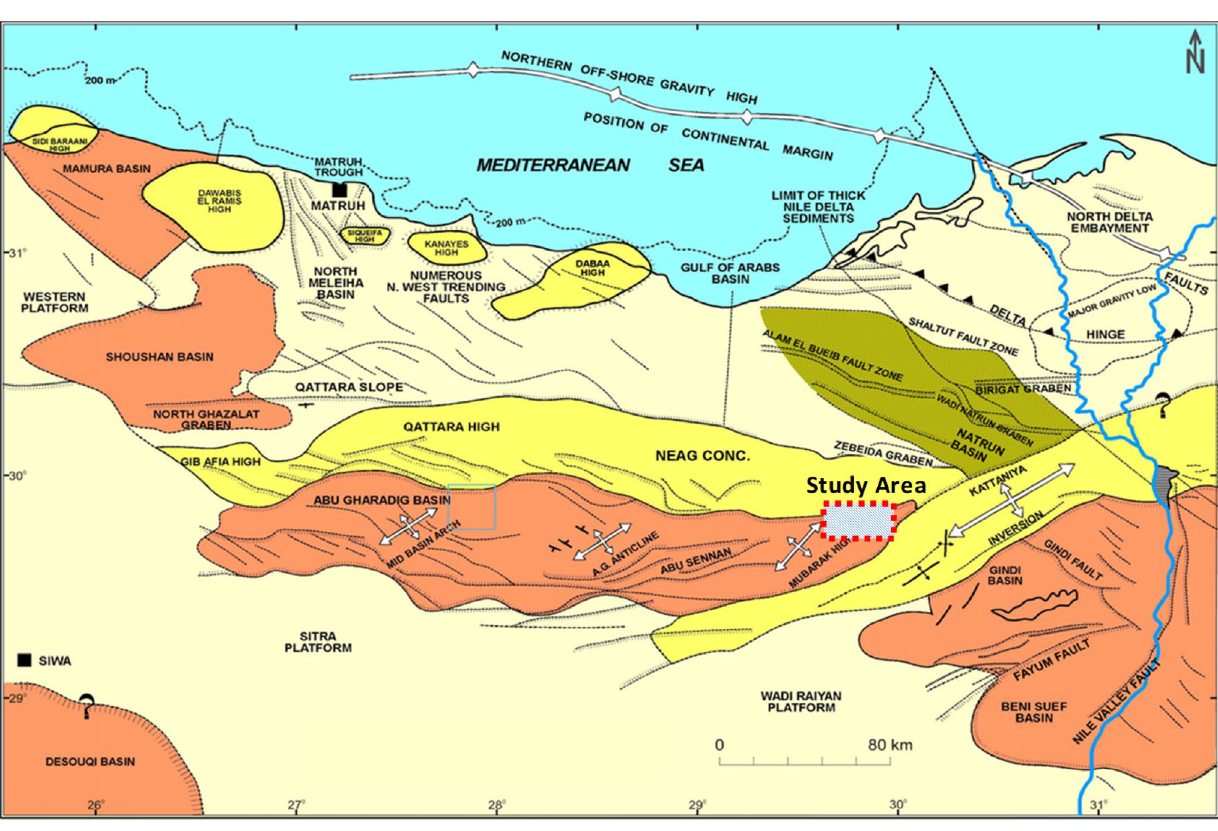
Fig. 2 Basic and major tectonic elements on Western Desert, Egypt (modified after Bayoumi